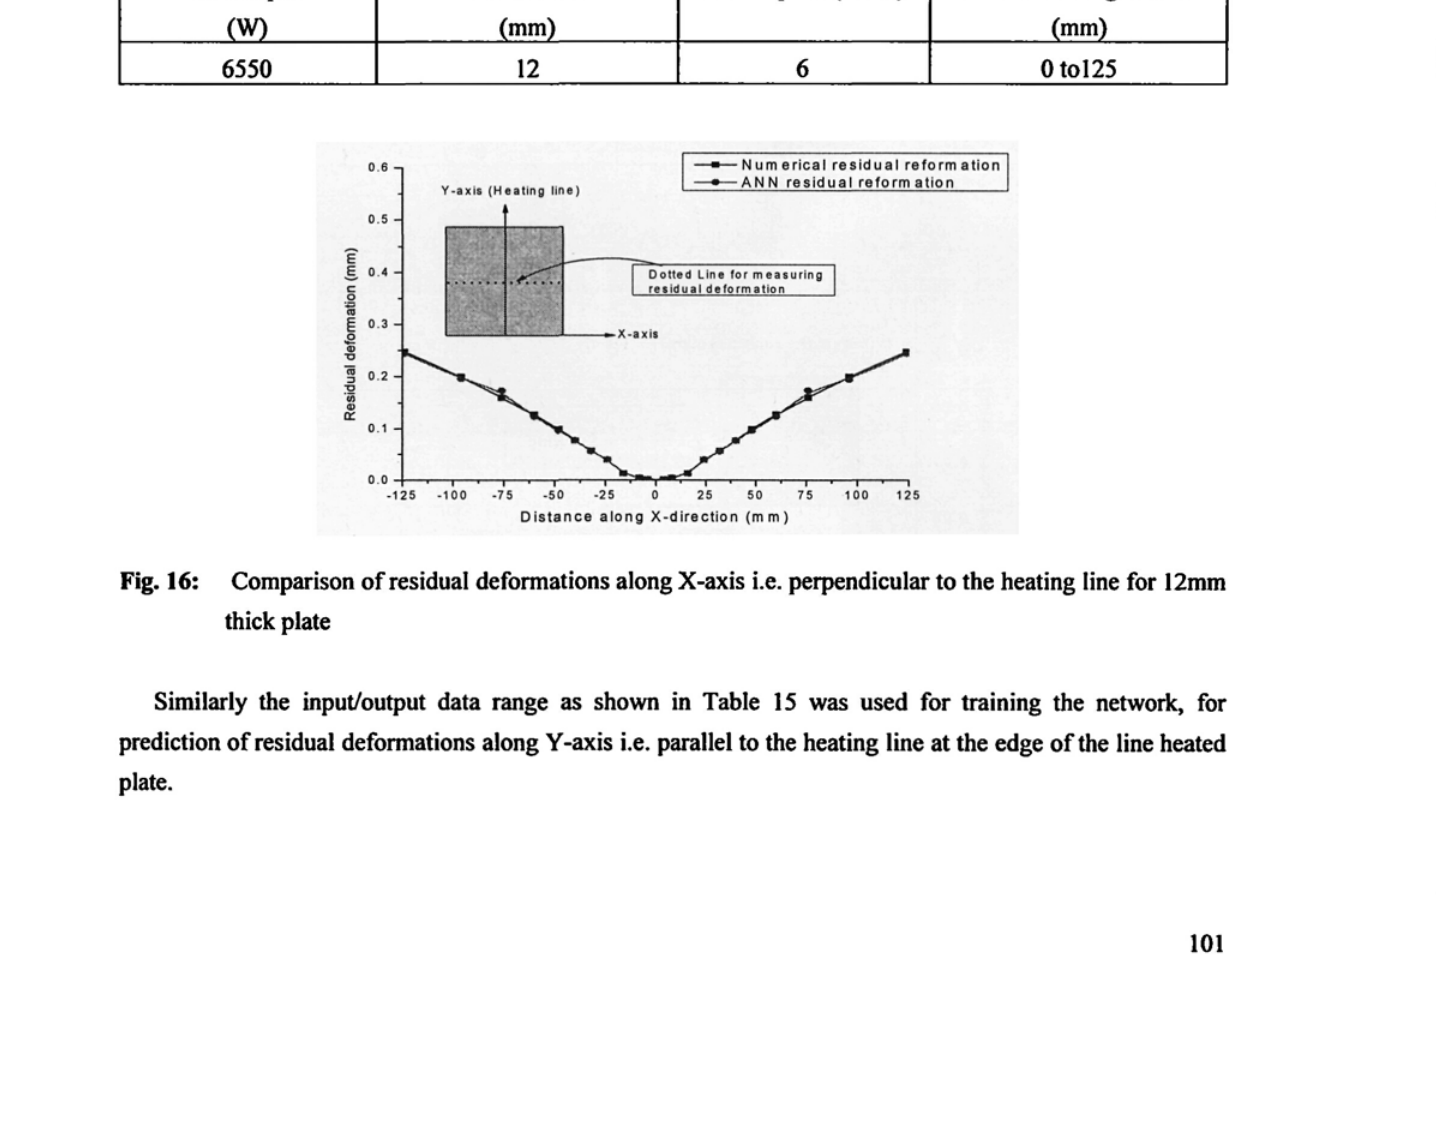
Input data for calculation of deformation perpendicular to heating line using ANN model